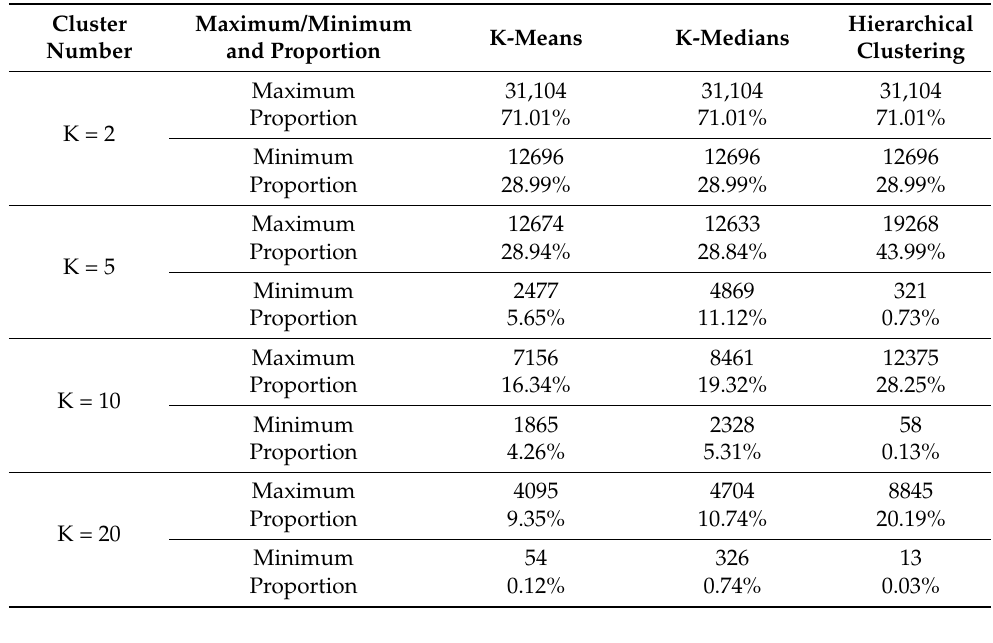
Table 4. The maximum and minimum amount of data in clusters when K = 2, K = 5, K = 10, and K = 20.